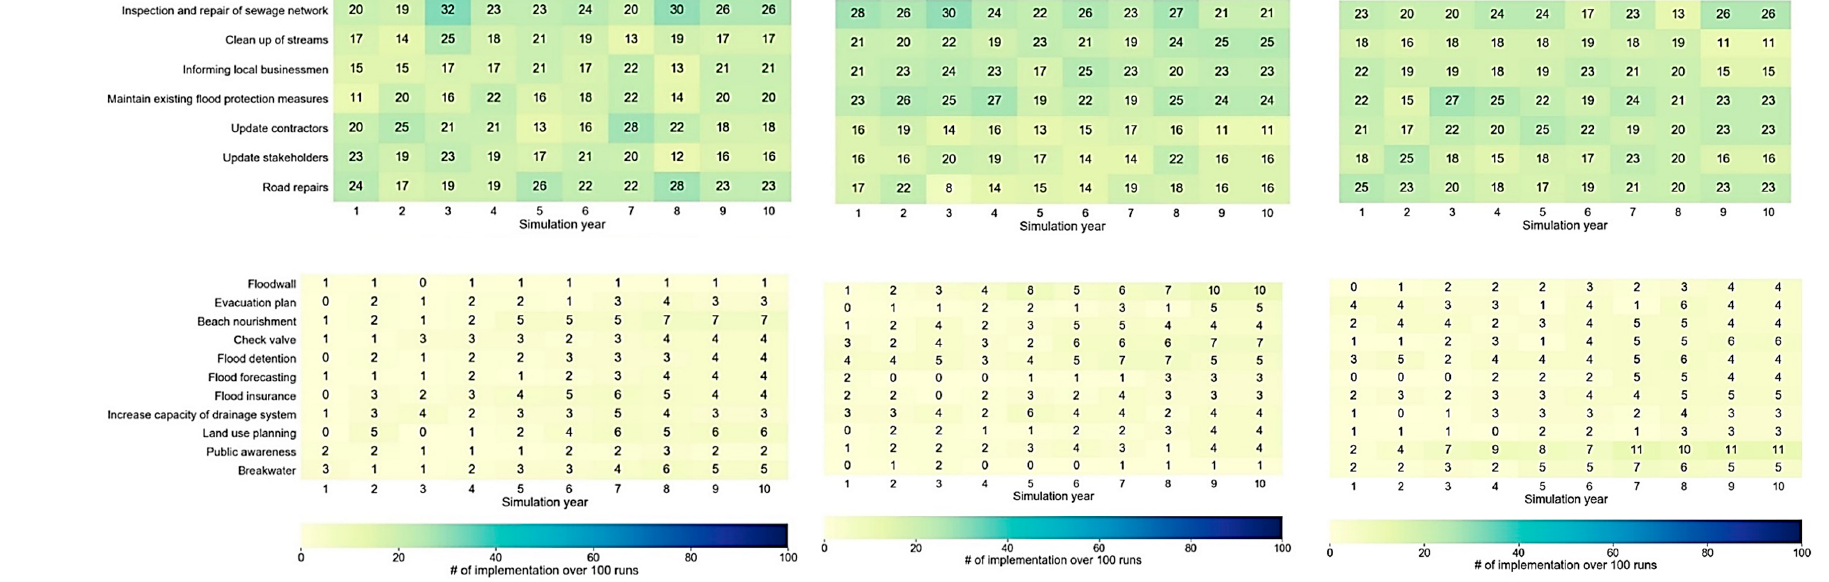
Figure 11. Heatmap of implemented actions ( up ) and measures ( down) per simulation year for no ( left ), low ( middle ) and high ( right ) flood events annually with insufficient funding and small interest from authorities.